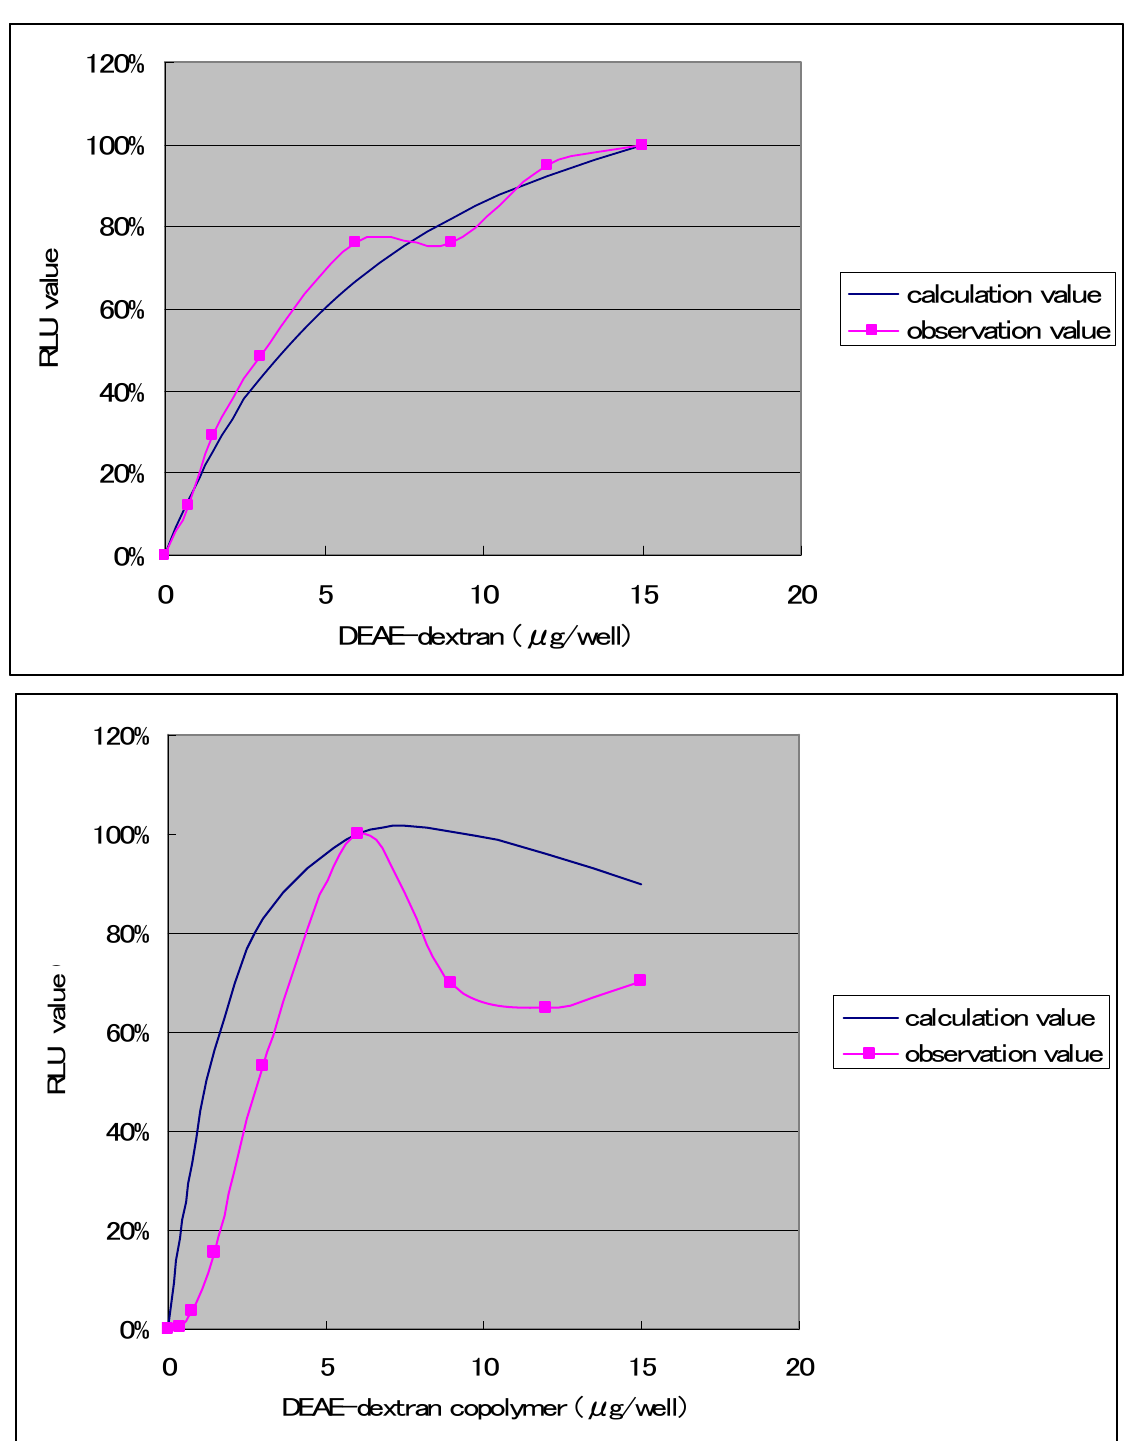
Figure 3. Transfection of COS-7 cells with samples of DEAE-dextran and DEAE-dextran- MMA graft copolymer having a grafting rate of 130% and including 0.075 μ g of DNA. Maximum luciferase expression within each experiment was set at